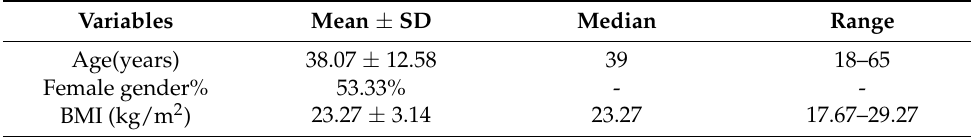
Table 1. Demographic, clinical examination, and ocular biometric parameters of